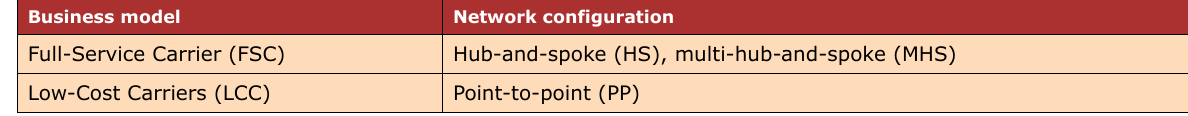
Table 1. Relationship between business models and network